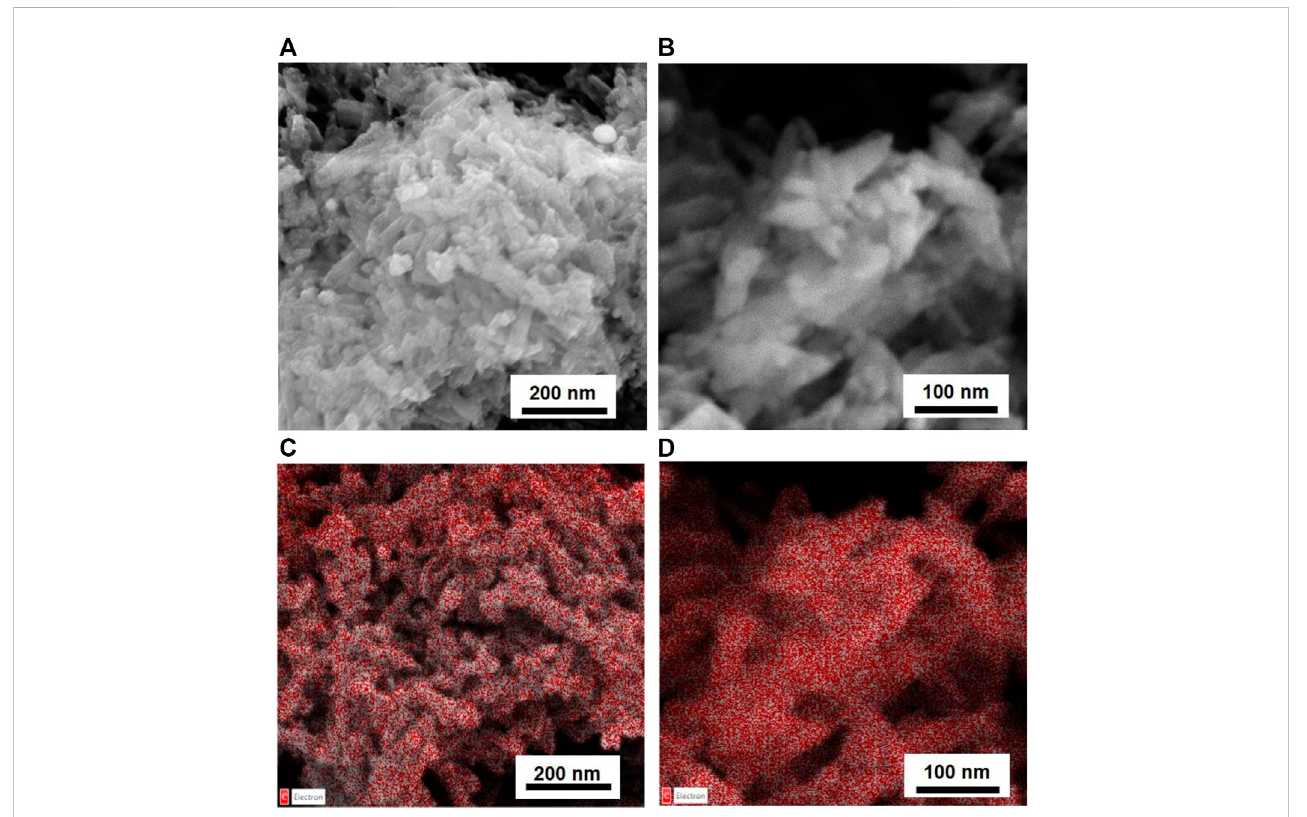
SEM images of HP NPs coated with HAs (A) and FAs (B) and EDS carbon maps (C) for HAs and (D) FAs.